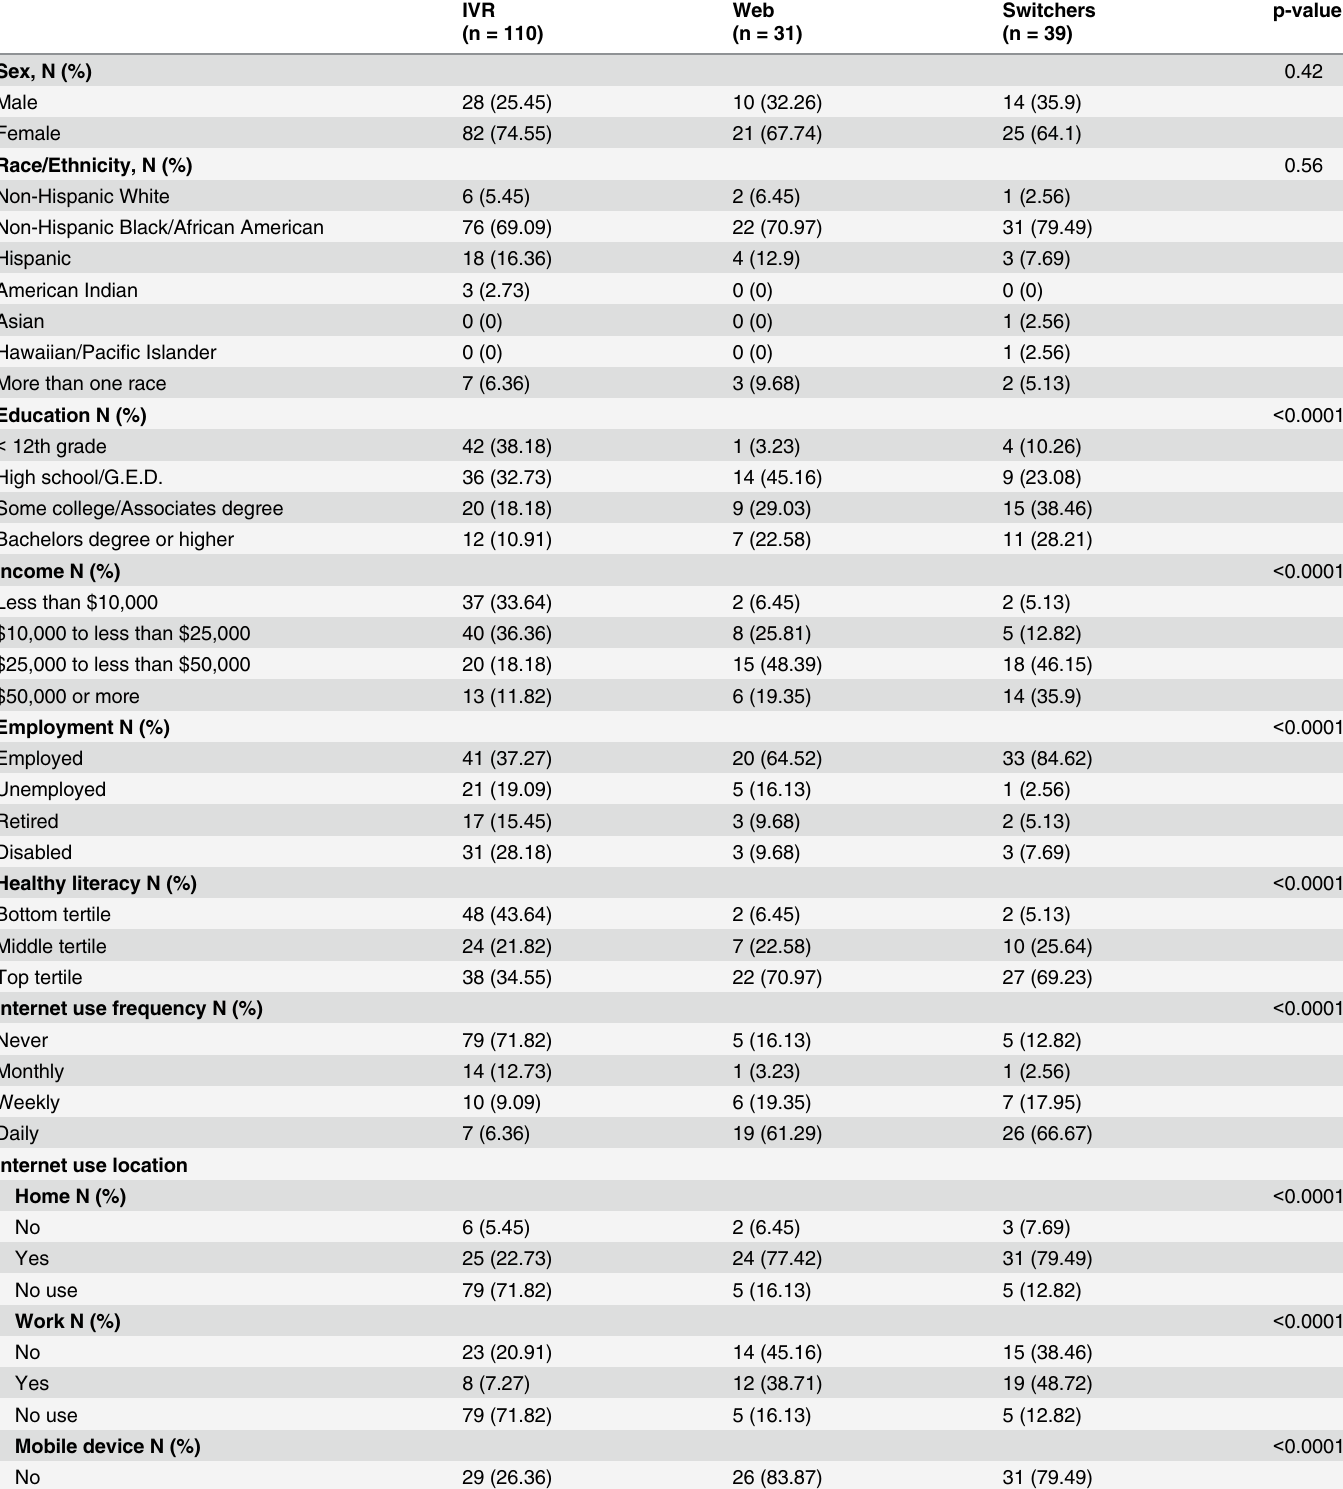
Table 1. Participant ’ s baseline characteristics by intervention modality (n =